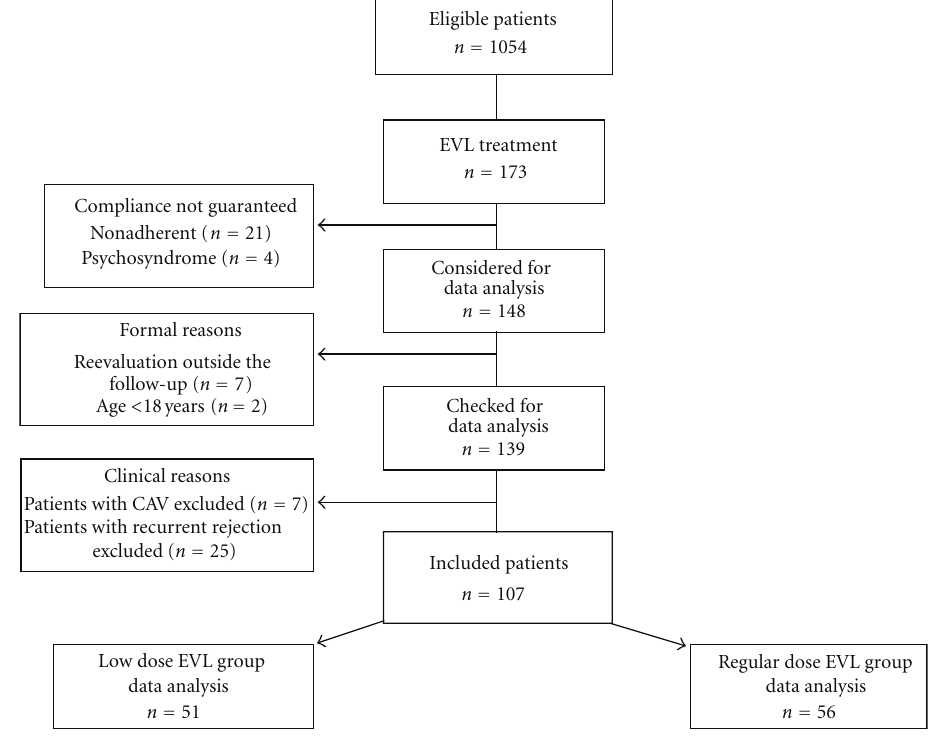
Figure 1: Study flow